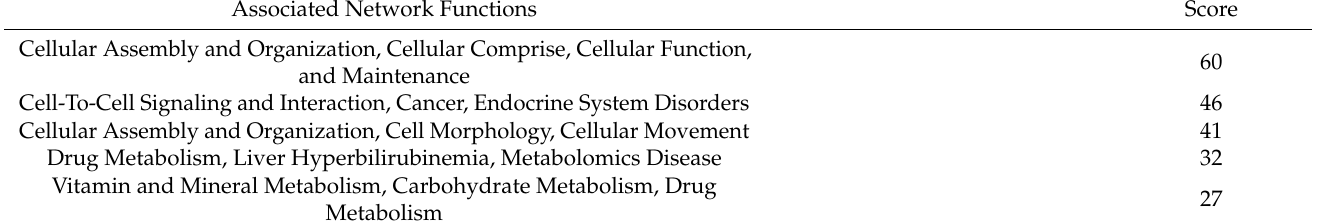
Table 2. Summary of IPA Analysis of di ff erentially expressed proteins between Caki-1 and Caki-2 cells. The top fi ve canonical pathways, the top fi ve molecular and cellular functions, and the top fi ve networks and their functions are provided.